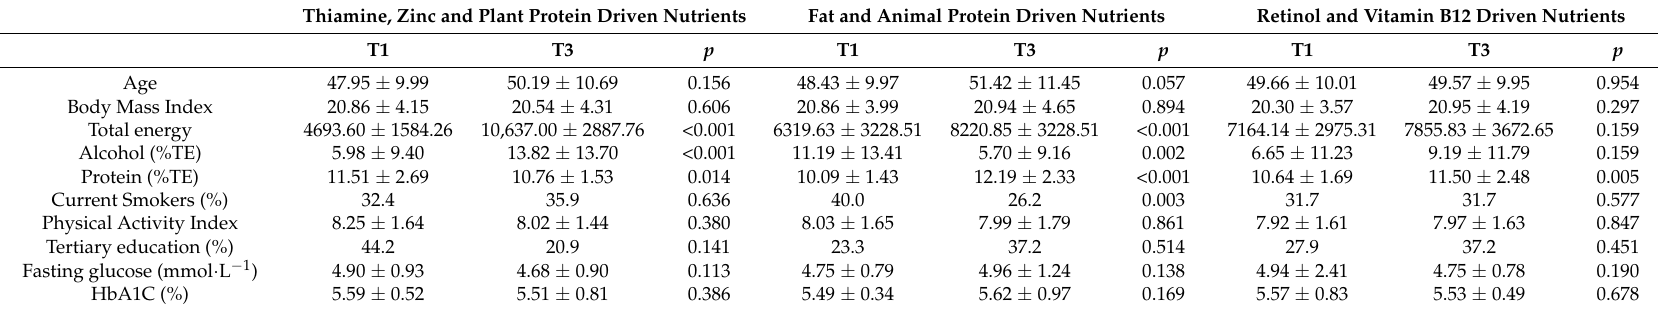
Table 2. Descriptive characteristics for the rural men of the study population according to the lowest and highest tertiles of the three nutrient patterns (PC). Thiamine, Zinc and Plant Protein Driven Nutrients Fat and Animal Protein Driven Nutrients Retinol and Vitamin B12 Driven Nutrients